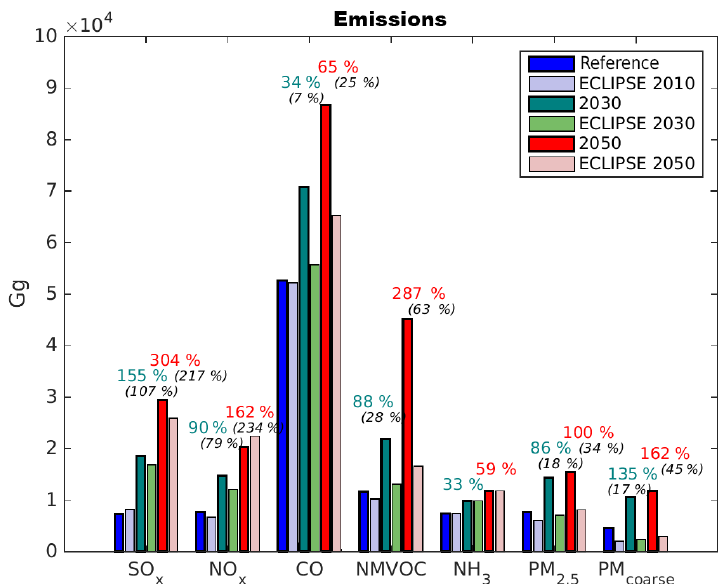
Figure 1. Annual emissions (in Ggyr − 1 ) used for the reference (2010), FC2030 and FC2050 scenarios (dark blue), and for 2030 (dark green) and 2050 (dark red), used for the FCE2030 and the FCE2050 scenarios over India, respectively. The variation of each compound with respect to the reference scenario is also provided by coloured percentage figure. The ECLIPSE emissions are also plotted for comparison and represented by light coloured bars. The variation of each compound with respect to ECLIPSE2010 scenario is also provided by italic black percentage figure given in